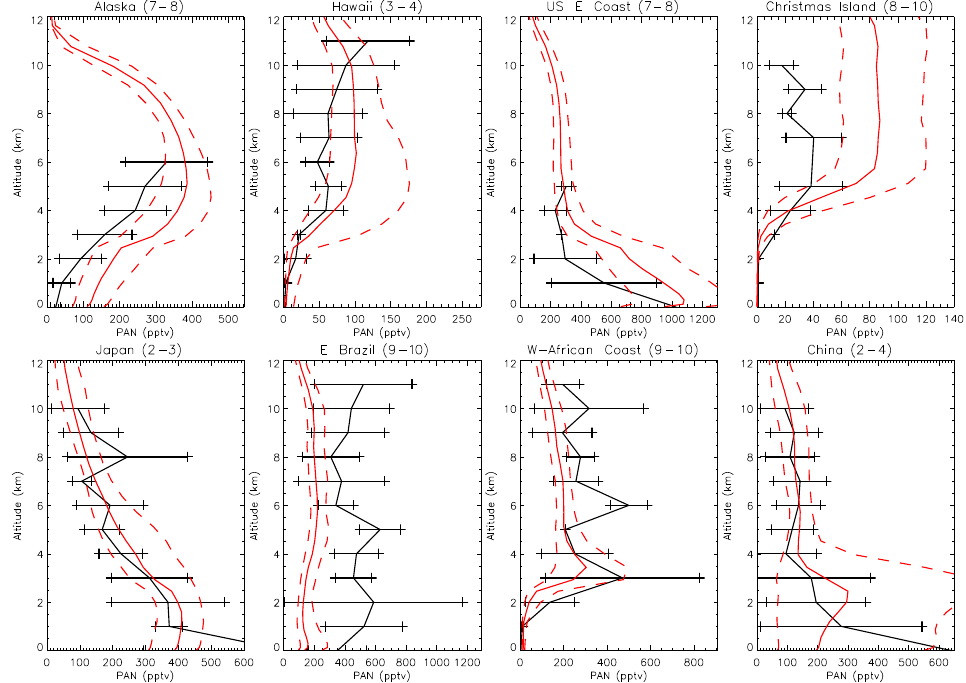
Figure 9. Vertical profiles of PAN from the Emmons et al. (2000) aircraft climatology (black) and the TOMCAT model (red) for eight different regions given in the panel titles The numbers in the title represent the months sampled. The TOMCAT PAN data have been averaged over the same locations and times as the measurements. The horizontal error bars are the observational standard deviations, and the dashed lines are the model 25th and 75th